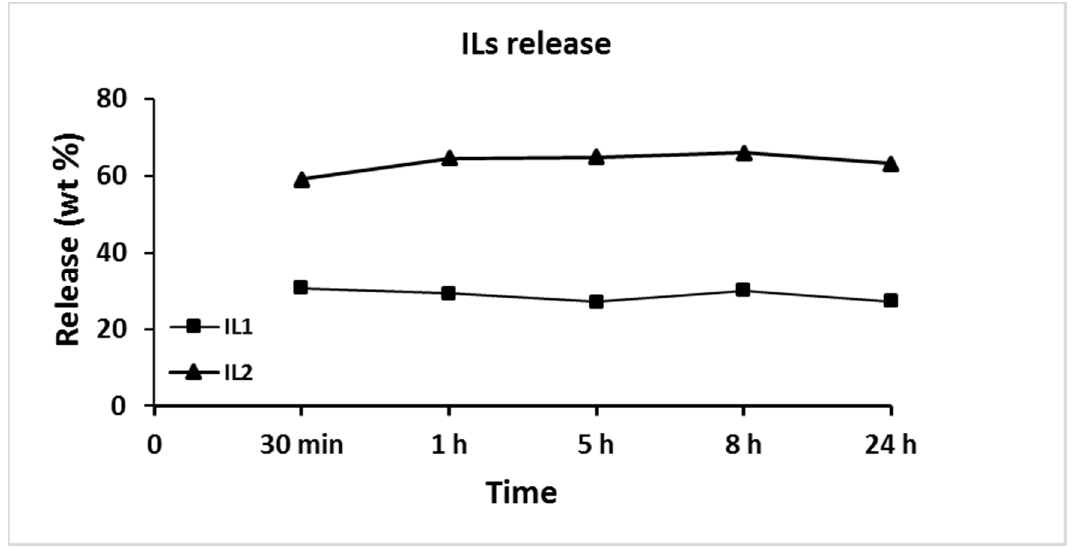
® Rnew / ILs blends containing ILs at a concentration of 5 Figure 7. ILs release in water from Pebax ® Rnew/ILs blends containing ILs at a concentration of 5 wt.%. Figure 7. ILs release in water from Pebax